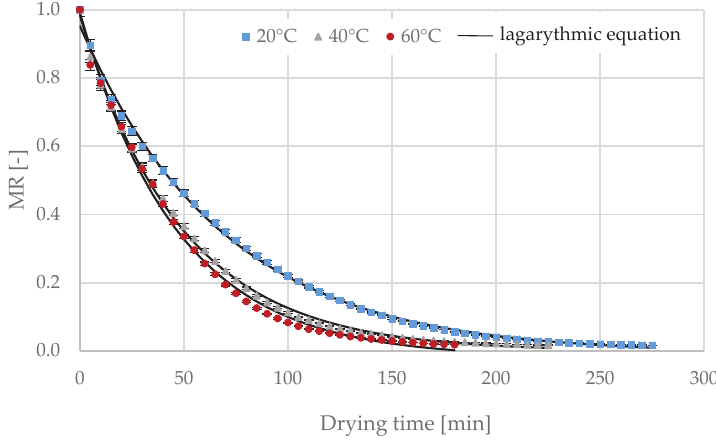
Figure 2. Drying curves of the vacuum drying of Moldavian dragonhead.